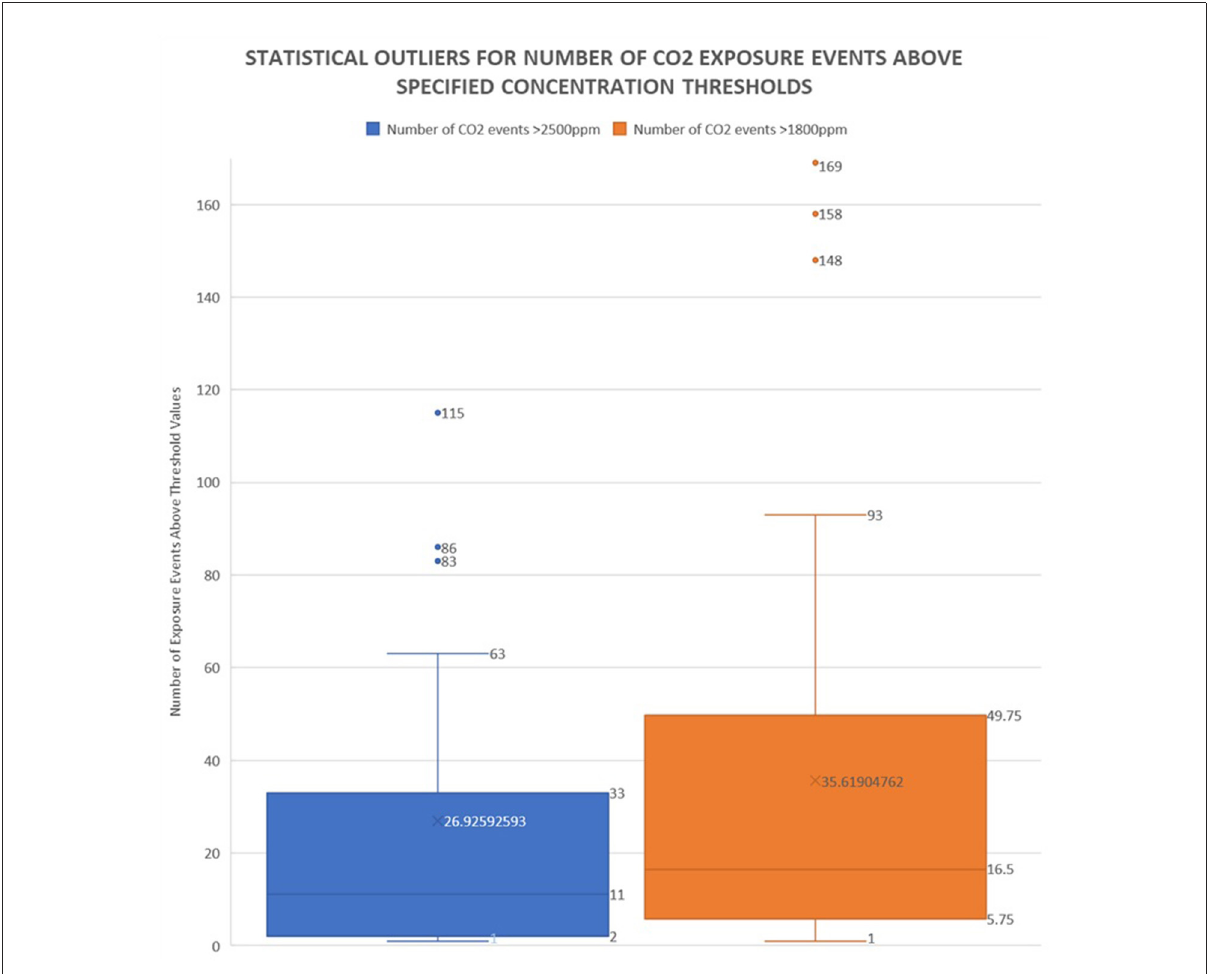
FIGURE3 Average number of exceedance events per classroom including